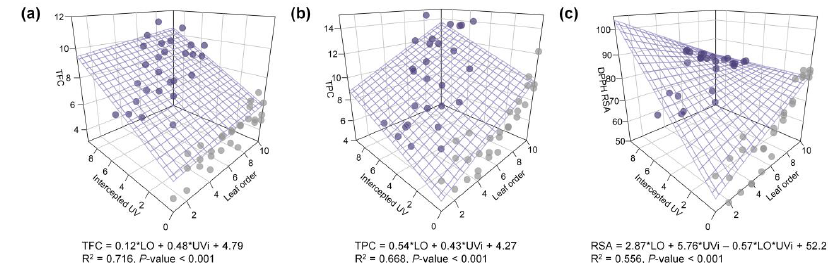
Figure 5. Multiple regression models for total flavonoid content (TFC, mg CE g −1 DW, ( a )), total phenolic content (TPC, mg GAE g −1 DW, ( b )) and antioxidant capacity represented as DPPH radical scavenging activity (RSA, %, ( c )) with leaf order and biological effective UV radiation interception (kJ m −2 d −1 ). The plane or surface showed linear or nonlinear re- gression model of the entire data set ( n = 56), and the regression equation, R 2 , and p -value are shown below the graph.